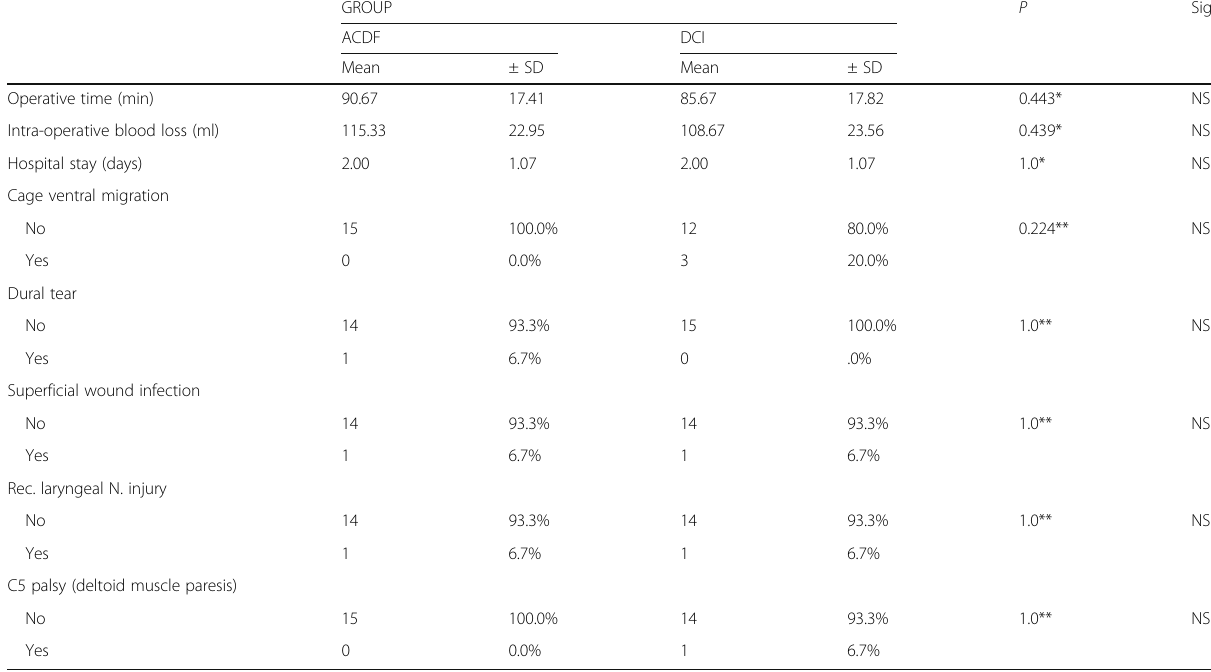
Table 9 Perioperative data and operative complications